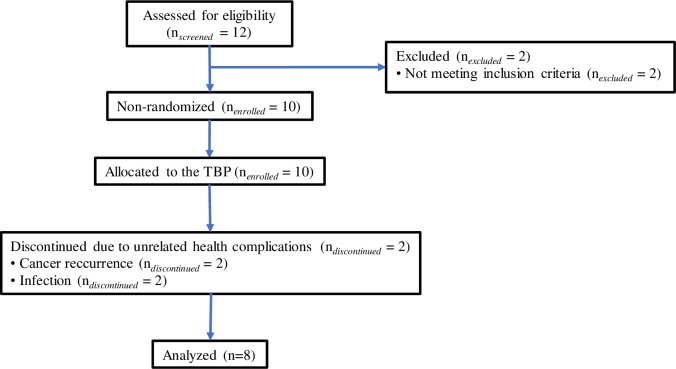
TREND flow diagram.Description of study population recruitment.